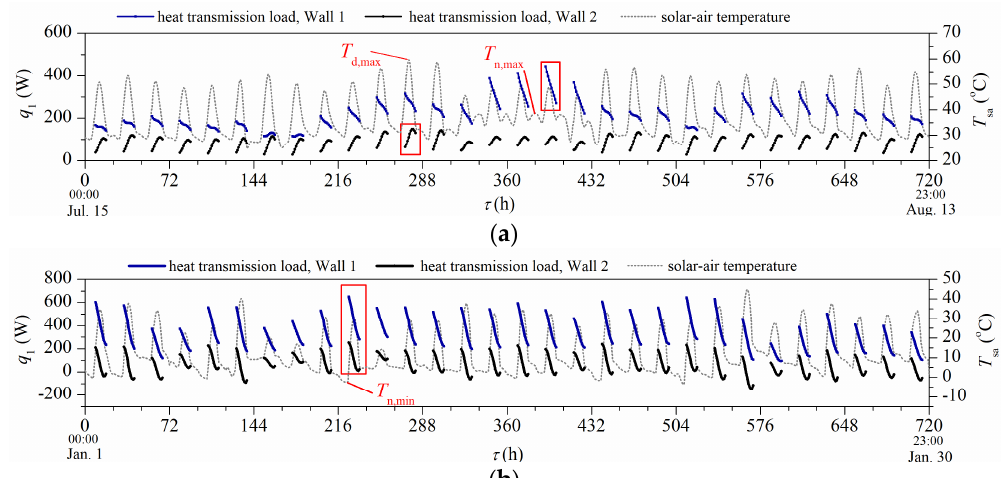
Figure 8. Hourly variations of the transmission load; ( a ) in cooling season; ( b ) in heating